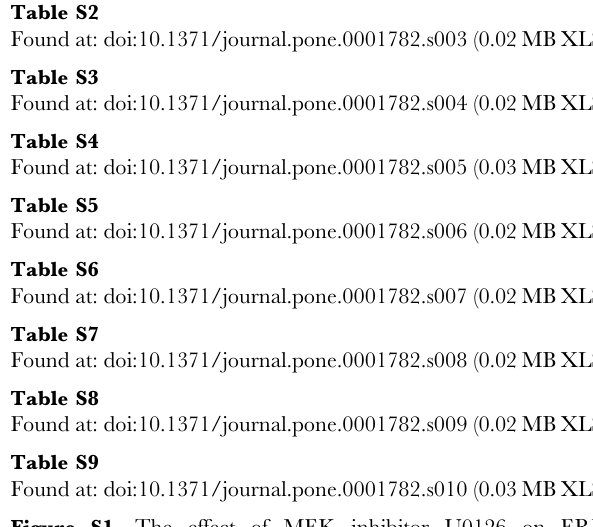
Figure S1 The effect of MEK inhibitor U0126 on ERK phosphorylation in E1 and E1/4 cells. Serum-starved E1 and E1/4 cells were incubated with 10 nM EGF for the indicated time period with or without pretreatment of 200 nM U0126. ERK phosphorylation was analyzed by Western blot with the corre- sponding anti-phospho-specific ERK antibodies (upper panel), and then reblotted with an anti-ERK antibody (lower panel). (A) Western blot for E1 cells. (B) Western blot for E1/4 cells. Data show a representative figure of three independent experiments. Figure S2 Transfer function model of the signaling pathways. (A) The substrate S is activated by E act and deactivated by E deact . The activator E act and deactivator E deact can be indirectly activated by ligand. (B) Figure shows a practical example of (A). When the substrate S is Raf-1, the activator E act corresponds to Ras-GTP that is indirectly activated by EGF through some signaling molecules such as Shc, Grb2, and SOS. (C) The intermediate reactions between L and E act (E deact ) are approxi- mated by the first-order transfer function with the time constant